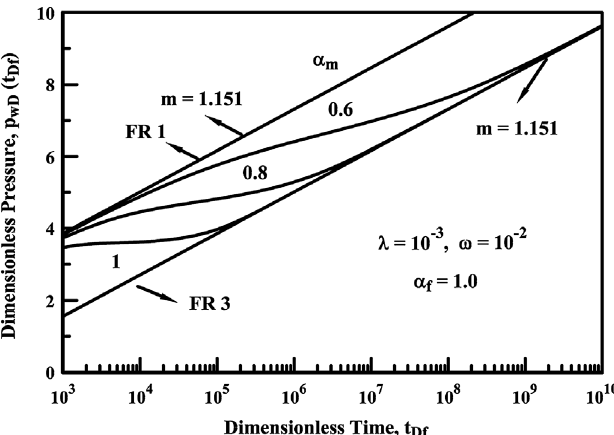
Figure 1. The well response for production at a constant rate; dimensionless pressure, p wD . The in fl uence of the exponents for the faster and slower regions is demonstrated. The faster region is assumed to obey classical diffusion; that is, a f = 1; the slower system assumes subdiffusive fl ow and three values of the exponent a m : 1, 0.8 and 0.6.